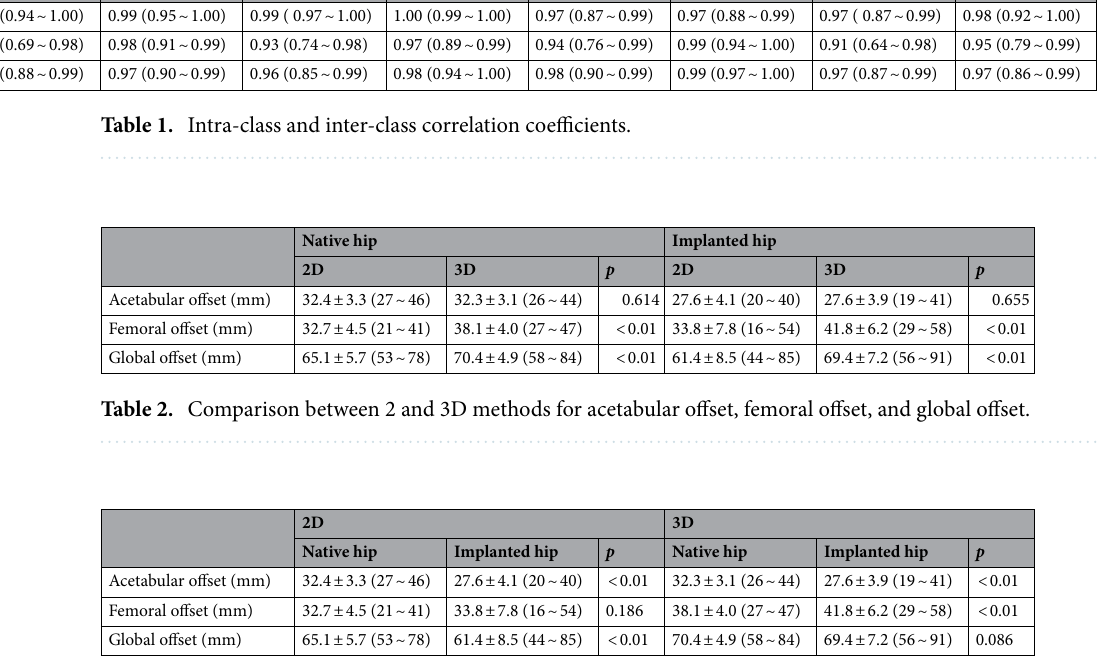
Table 3. Comparison between native and implanted hips for acetabular offset, femoral offset, and global offset.